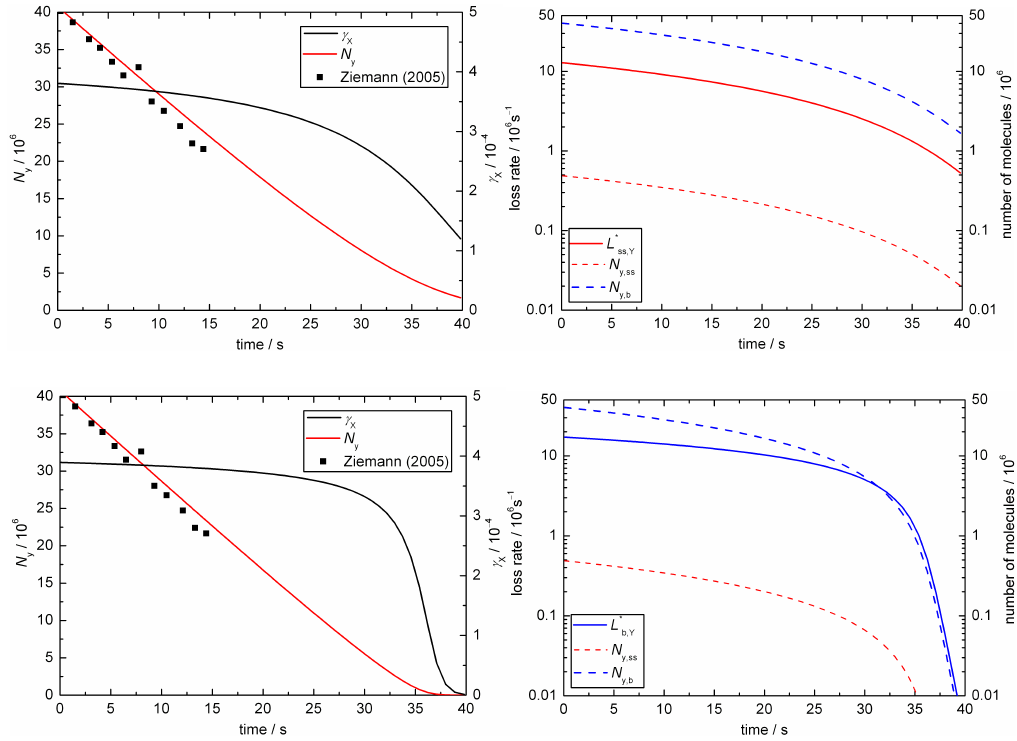
Fig. 7. Temporal evolution of aerosol particle composition and kinetic parameters in sensitivity studies for BC1 with chemical reaction occurring only at the surface (a–b) or only in the bulk (c–d) . Plots are analogous to Fig. 2a and Fig.